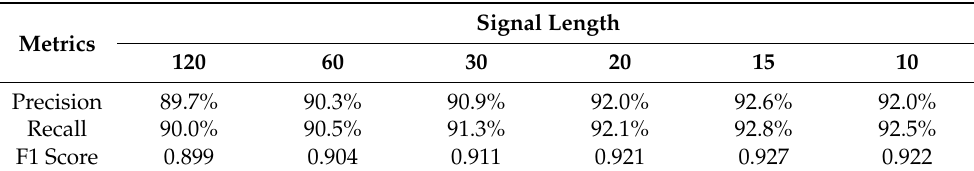
Table 6. Other metrics of MobileNet for WA filtering